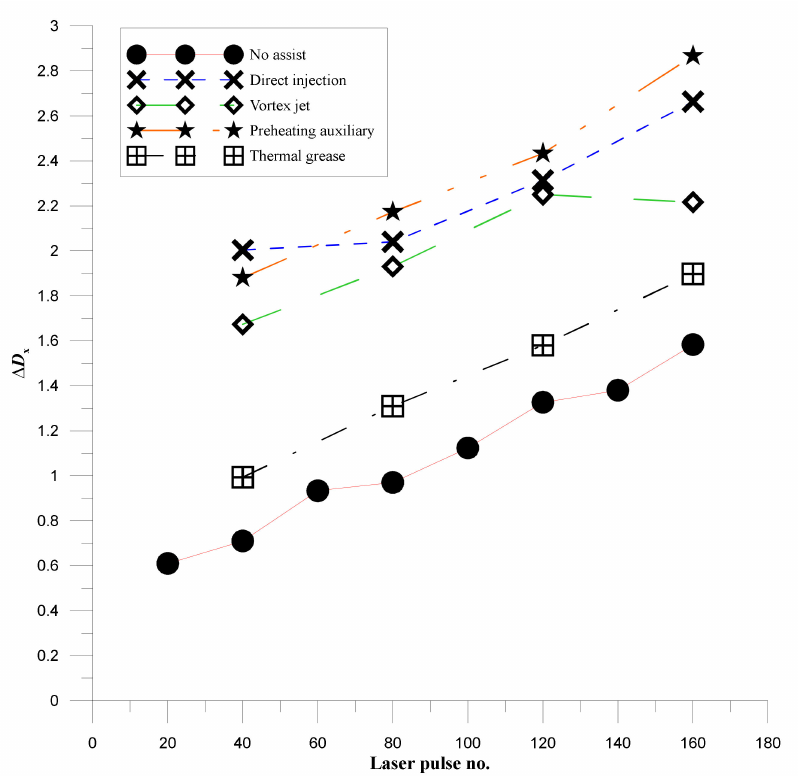
Figure 9. Curves of laser emission and deformation difference for laser processing with different auxiliary